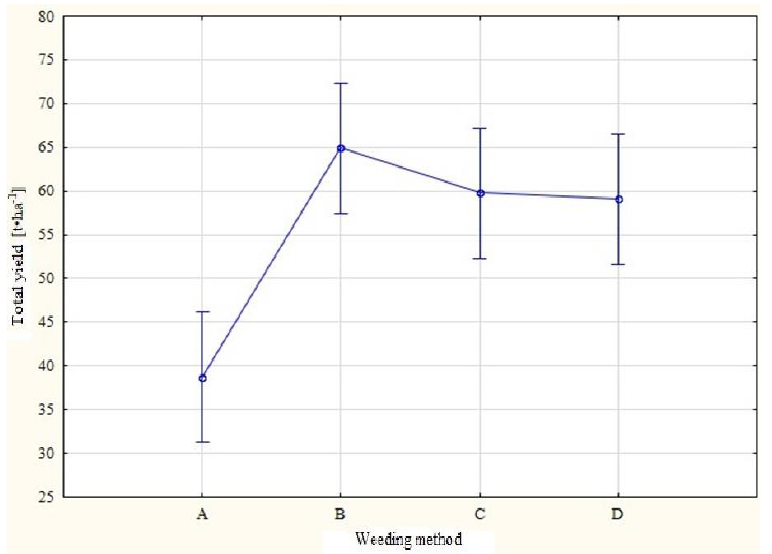
Figure 8. Expected marginal averages for 0.95 confidence intervals in total onion yield in 2017 (source: own work).